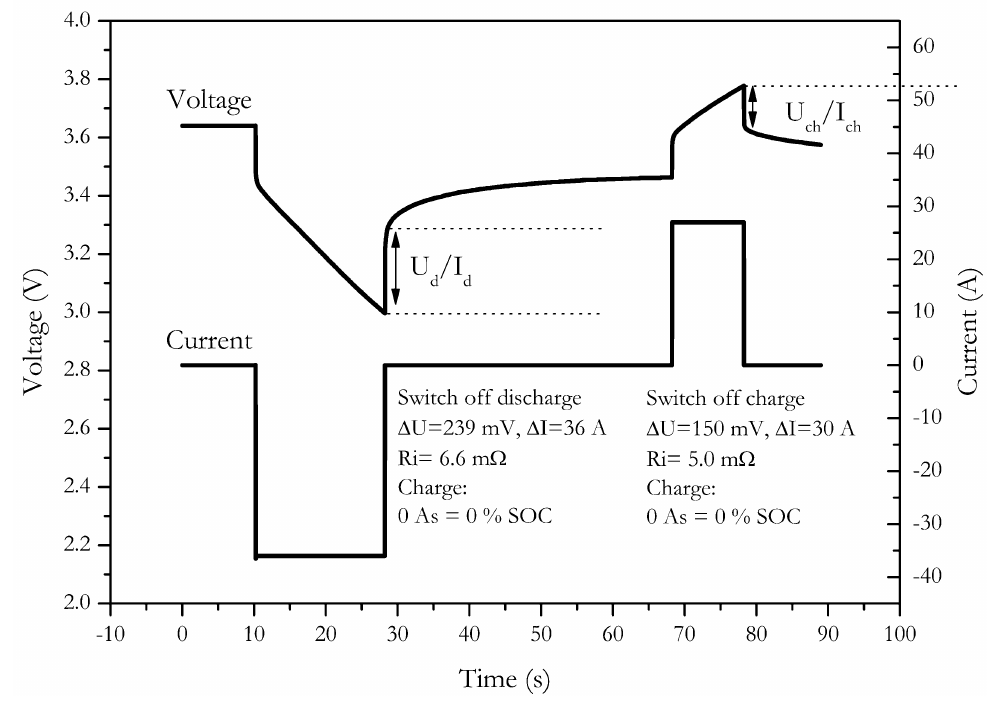
Figure 7. Measurement of internal resistance by switching off the pulse current.